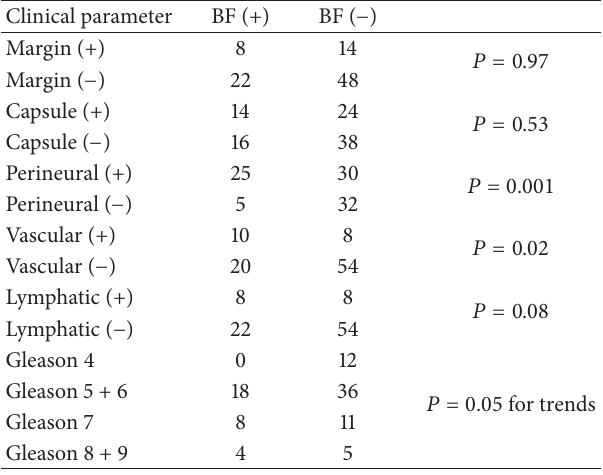
Table 3: Biochemical failure and association with clinical parame-